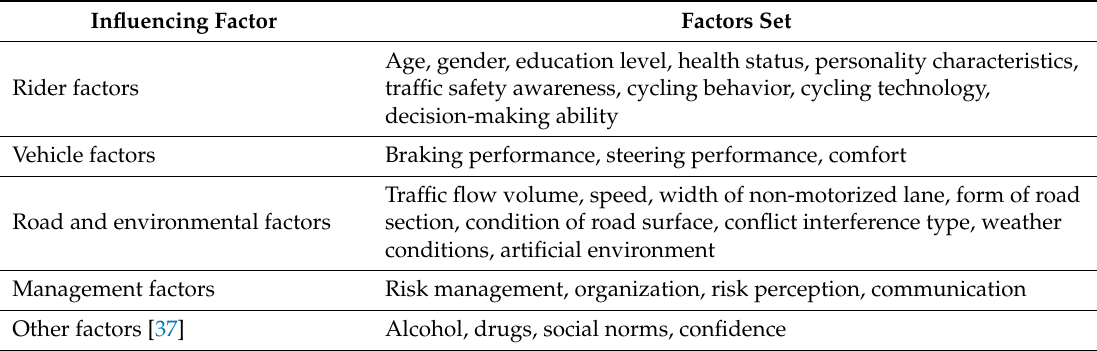
Table 1. Influencing factors of electric bicycle (e-bike) risky riding